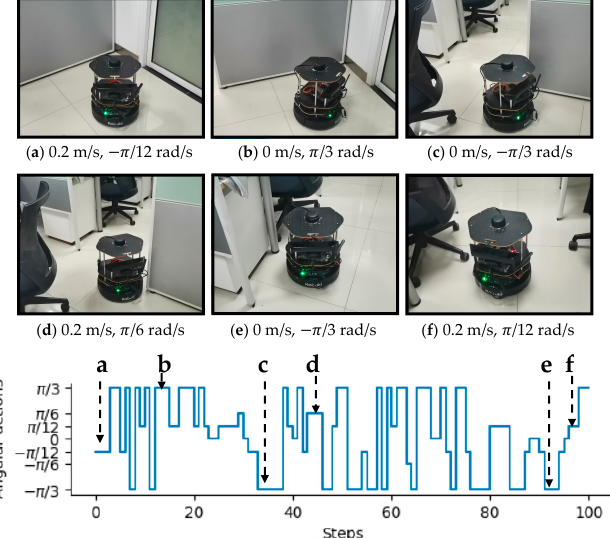
Editable version Figure 11. An example of dealing with obstacles in a real-world office environment. The subfigures